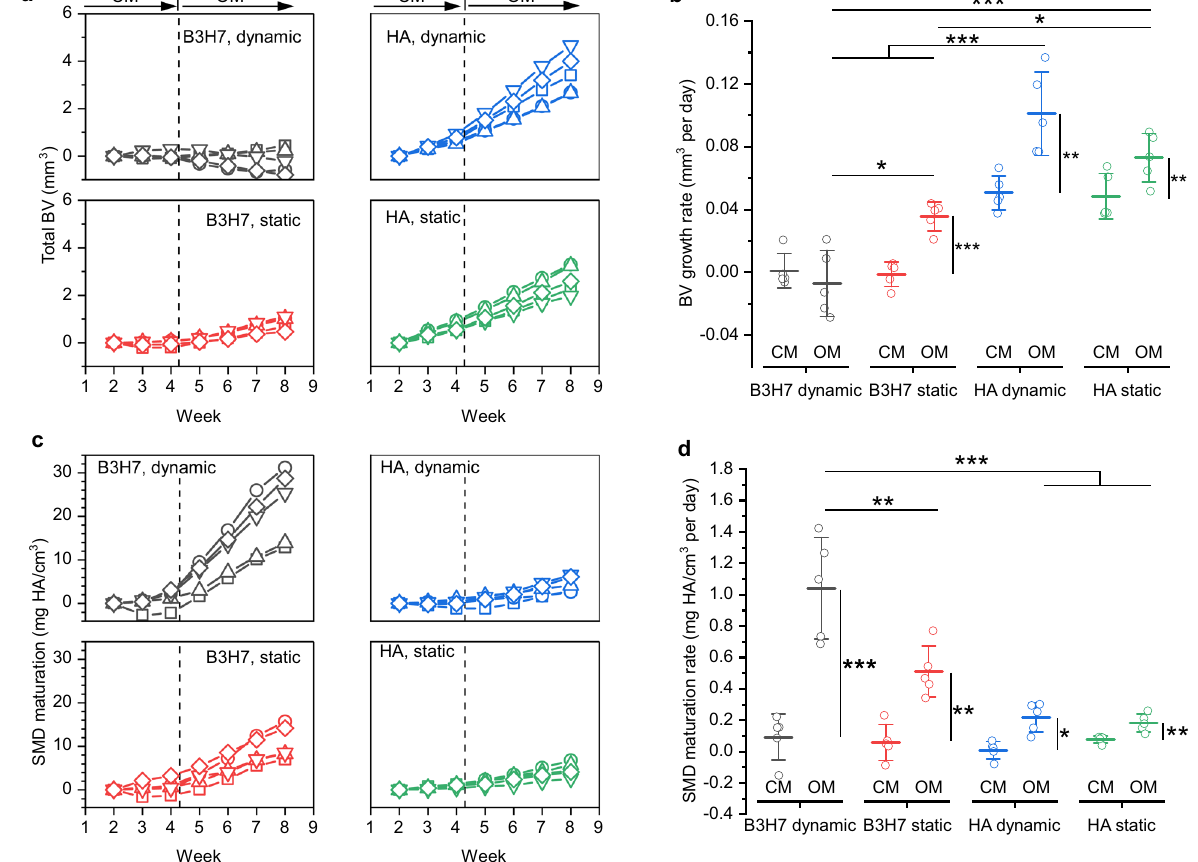
Fig. 5 Mineral formation kinetics in B3H7 and HA scaffolds. a Total bone volume (BV) for scaffolds containing pure hydroxyapatite (HA) and a mixture of barium titanate and hydroxyapatite (B3H7) under dynamic and static conditions ( n = 5 for each group). On day 30 (vertical dashed line), the culture medium was switched from control medium (CM) to osteogenic medium (OM). b BV growth rates during culture in CM and OM obtained from linear fi ts of the data points in a . c Scaffold mineral density (SMD) maturation. d the corresponding rates. * p < 0.05, ** p < 0.01, *** p < 0.001; longitudinal groups were tested with paired t -test, one-way analysis of variance (ANOVA) with post hoc Bonferroni correction to compare multiple groups separated by CM or OM. In b for CM, the groups HA dynamic/static are signi fi cantly different from B3H7 dynamic/static; *** p < 0.001. Shapiro – Wilk normality test was not signi fi cant. Data are shown as mean ± B3H7 scaffolds, switching to osteogenic medium had only an effect for scaffolds cultured under static conditions.